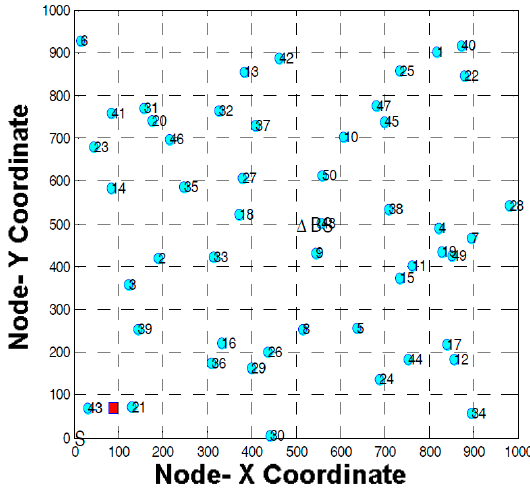
Figure 5. Randomly deployed node in the wireless sensor network (WSN). Future Internet 2017 , 9 , 54 13 of 20